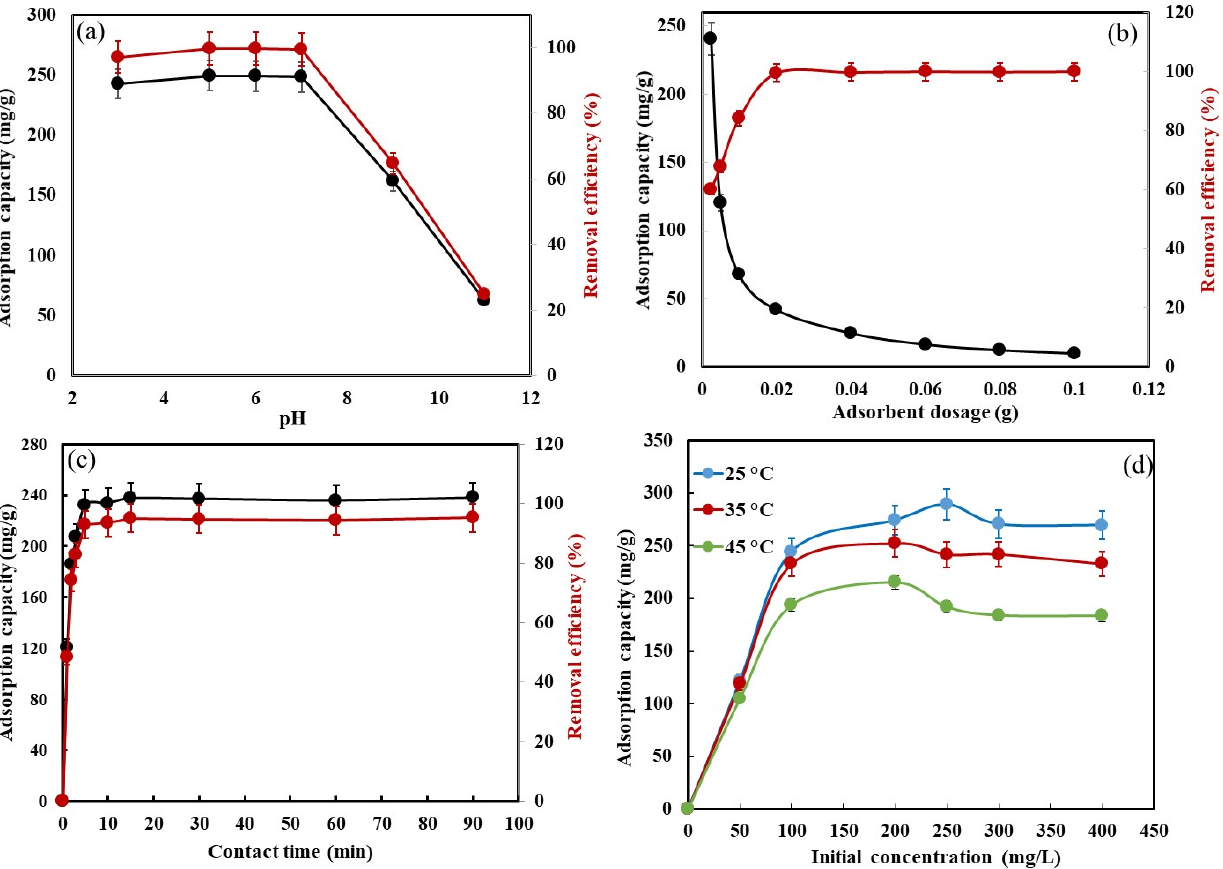
Figure 6. Effects of pH ( a ), adsorbent dosage (g) ( b ), contact time (min) ( c ), and initial concentrations (mg/L) ( d ) on the adsorption of CR dye onto CS-HAP-CeO 2 heterostructure.